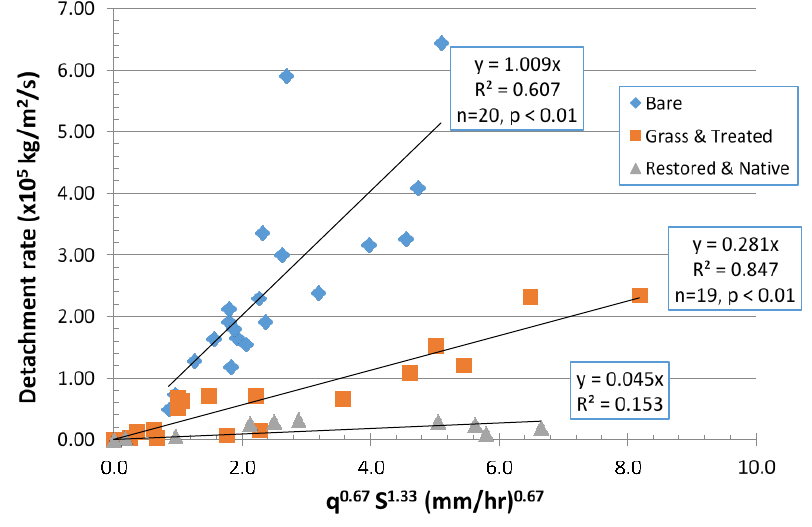
Figure 6. Comparison between and stream power variables for granitic RS plots on the southwest shore of Lake Tahoe.